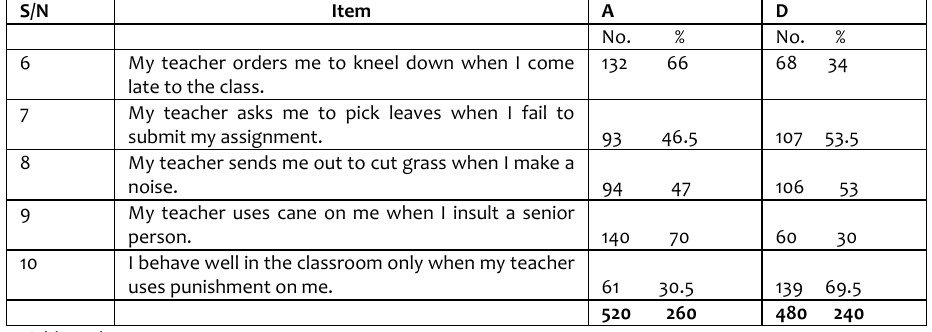
Figure 2: Percentage Presentation of data for question 2